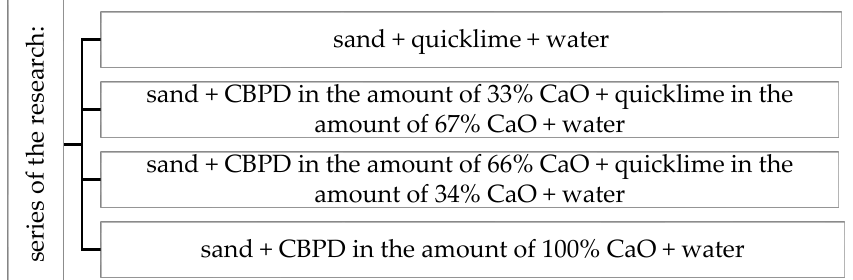
Figure 2. Scheme of the research carried out.